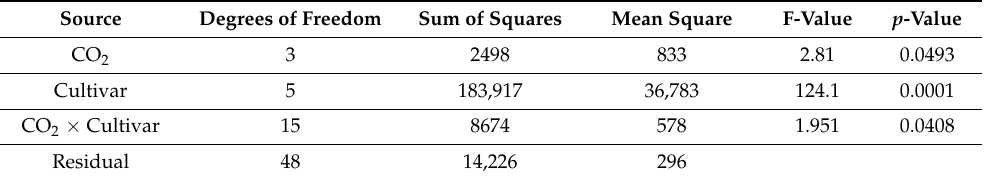
Table A1. Analysis of variance for area of third leaves of six bean cultivars grown at 23 ◦ C with four day/night CO 2 conditions.